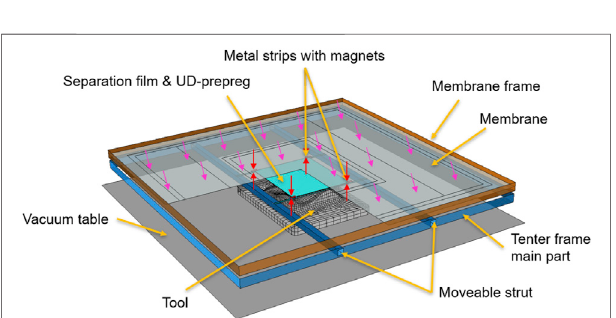
FIGURE 6 | Schematic FE model of the single diaphragm forming process. A quadrant of the membrane is removed to have a better view onto the layup, the clamping system, and the tool. Magnetic clamping pressure is indicated with red darts. Vacuum pressure is indicated with pink darts.